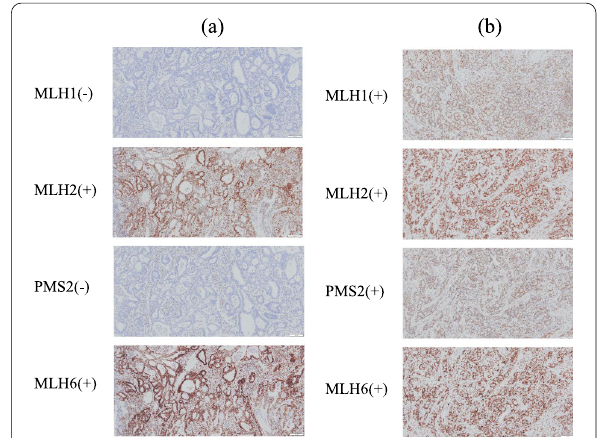
Fig. 4 Immunohistochemical findings of mismatch repair (MMR) proteins in a representative colliding gastric adenocarcinoma (Case